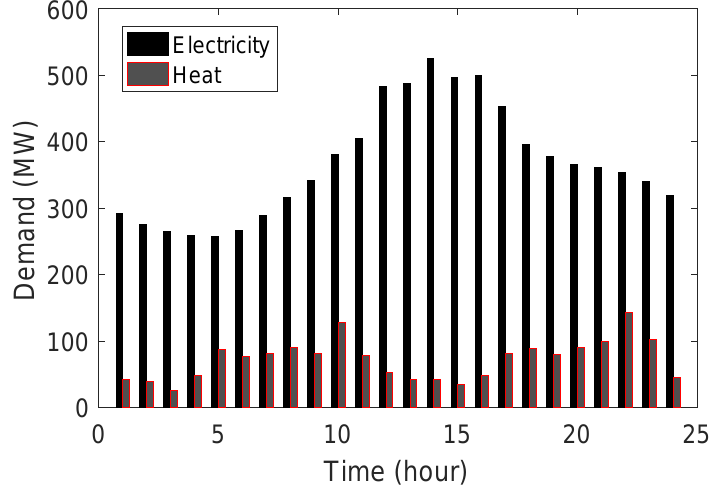
Figure 4. Power and heat demands. Table 1. The characteristic data of the case